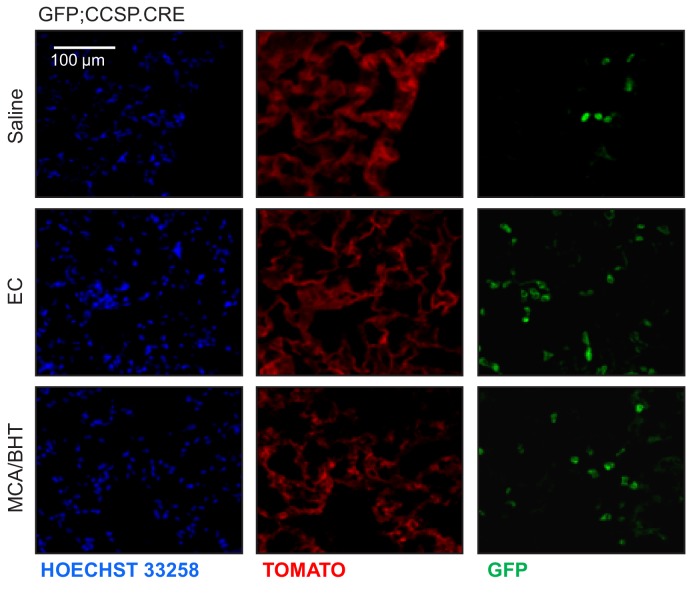
Airway-labeled cells in the alveoli of carcinogen-exposed C57BL/6 mice: representative images.Single-channel microscopy images (endogenous TOMATO and GFP labeling with Hoechst 33258 nuclear stain) of non-neoplastic alveolar regions of GFP;CCSP.CRE mice treated as in Figure 3A.